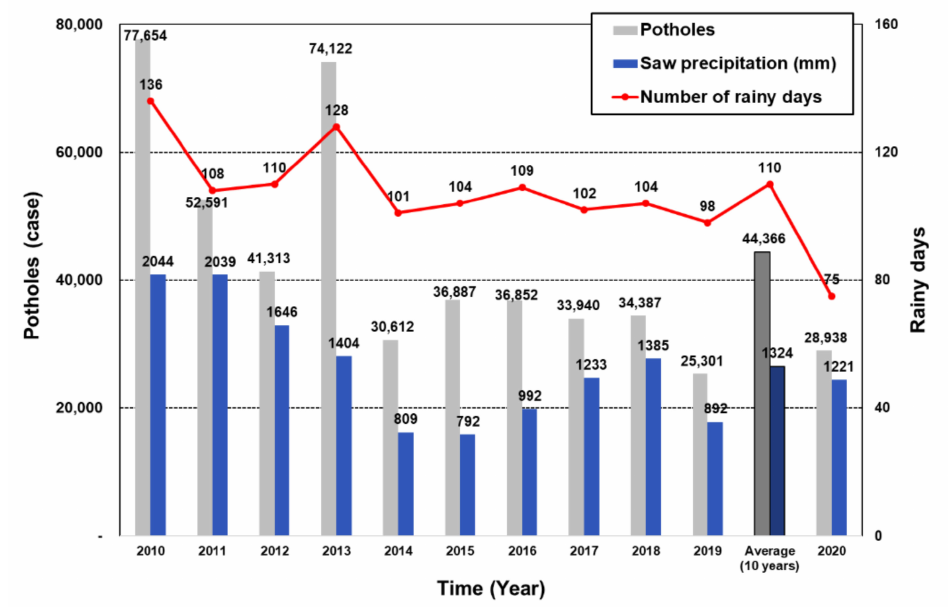
Figure 1. The amount of precipitation and the number of days that saw precipitation compared to the number of potholes